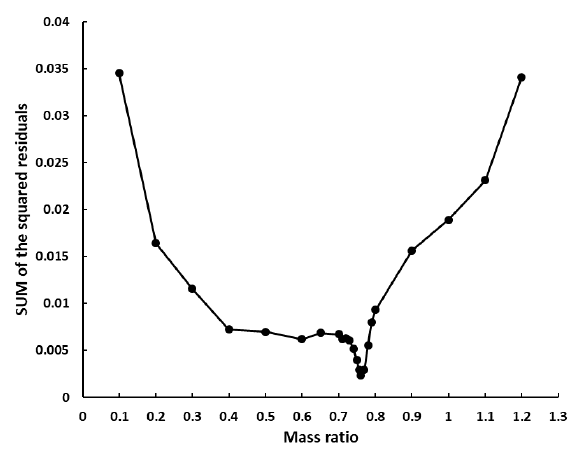
Figure 6. Sum of the squared residuals as a function of the mass